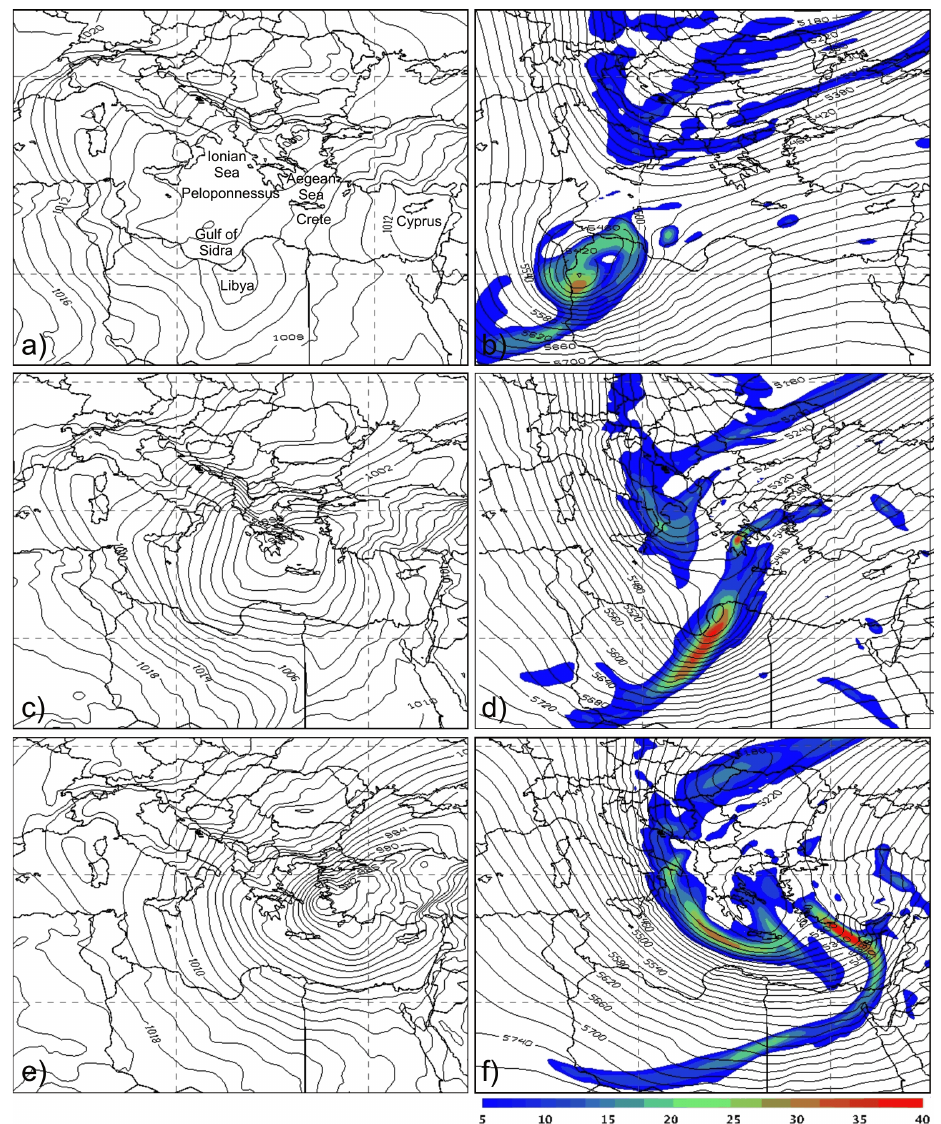
Fig. 1. (a) Mean sea level pressure (MSLP) in hPa at 12:00 UTC, 21 January 2004, (b) geopotential height (solid lines) at 500hPa with ab- solute vorticity (colour shaded; only values greater than 5.0 × 10 − 5 s − 1 are shown) at 12:00 UTC, 21 January 2004, (c) MSLP at 00:00 UTC, 22 January 2004, (d) geopotential height at 500hPa with absolute vorticity at 00:00 UTC, 22 January 2004, (e) MSLP at 12:00 UTC, 22 January 2004, and (f) geopotential height at 500hPa with absolute vorticity at 12:00 UTC, 22 January 2004. The entire fields are based on ECMWF analyses